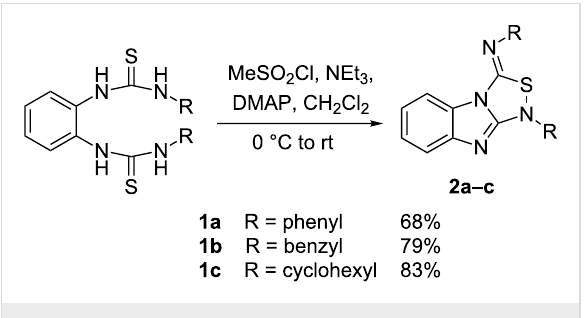
Scheme 1: Synthesis of tricyclic 1,2,4-thiadiazoles 2a–c